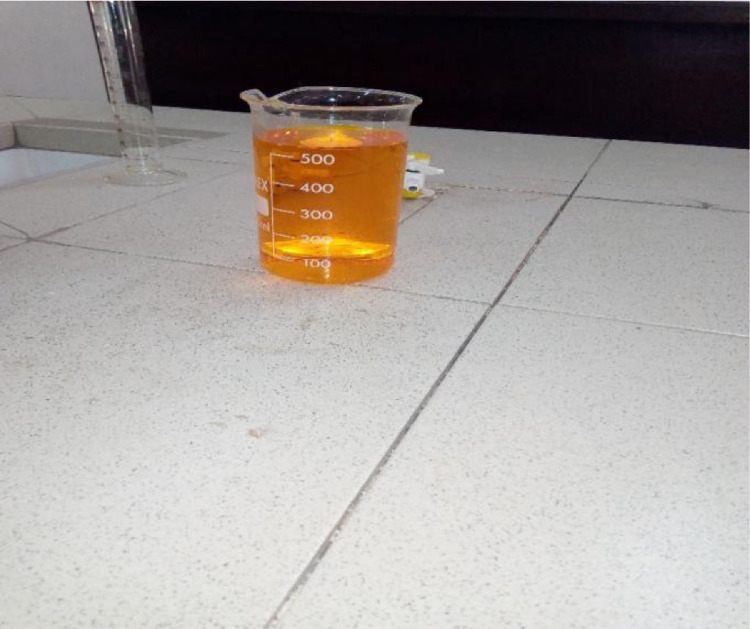
The liquid state of Kr2Cr2O7.